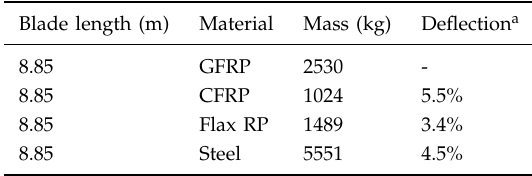
TABLE II M ATERIAL PROPERTIES USED IN THE FINITE ELEMENT